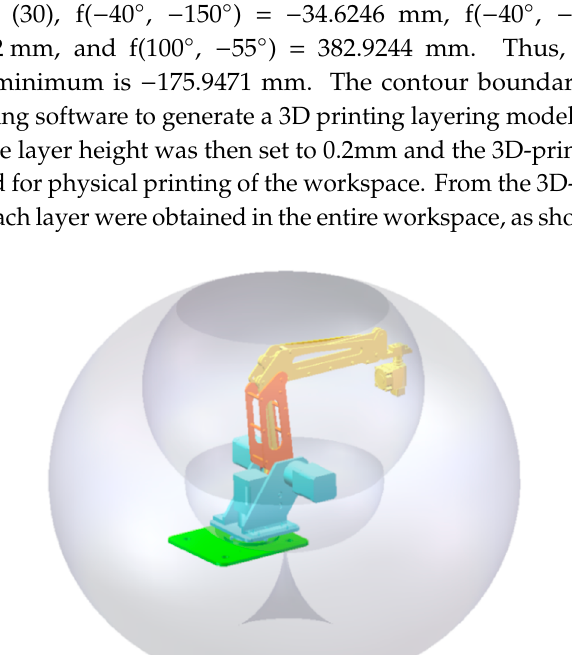
Figure 10. 3D workspace composed of boundary curves (nine layers).